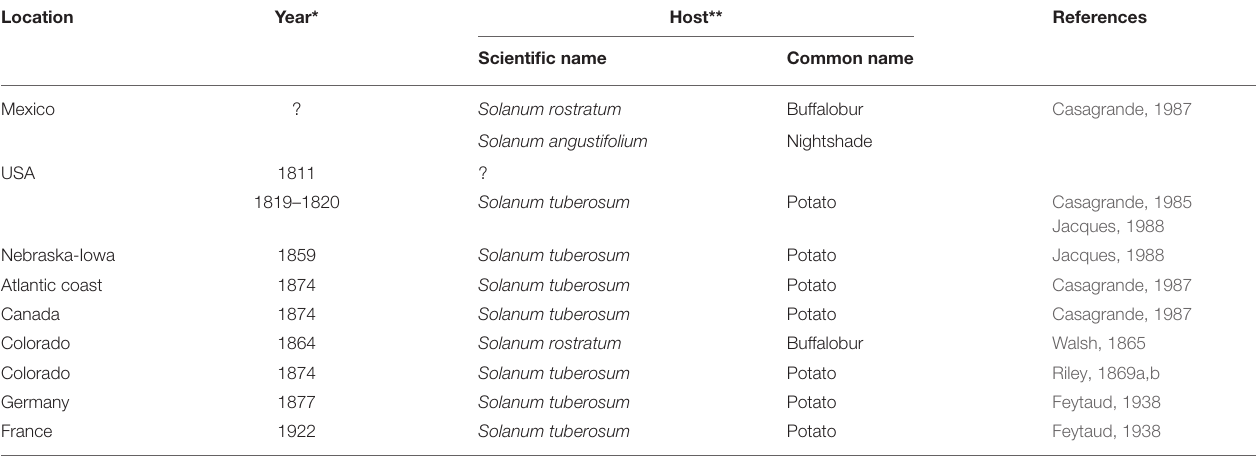
TABLE 1 | Initial historical expansion of Leptinotarsa decemlineata Say.